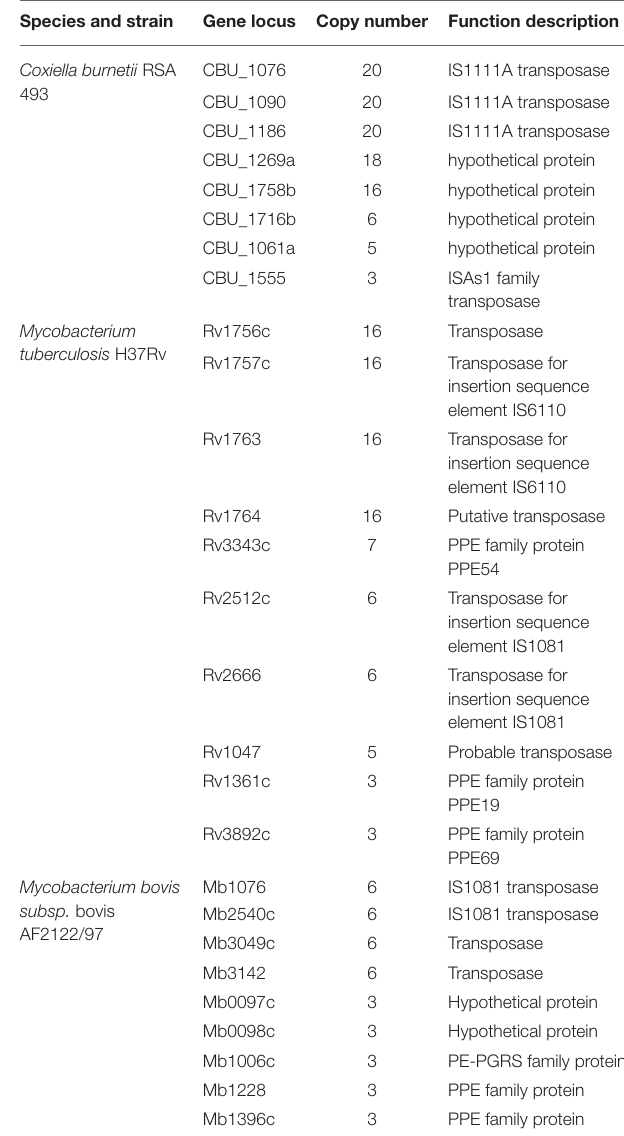
TABLE 5 | Selected multiple copy genes in genomes of Coxiella burnetii , Mycobacterium tuberculosis and Mycobacterium bovis . Species and